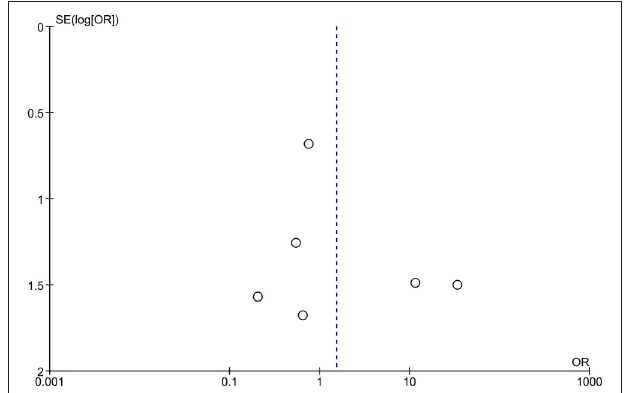
FIGURE 7 | Funnel plot of comparison for at least one AE. The funnel plot appeared asymmetric. Each small circle represents an independent study for the indicated association. AE, adverse